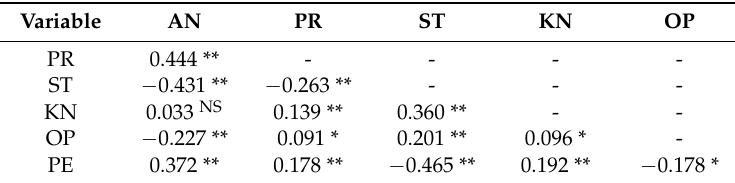
Table 3. Variable correlation coefficients.